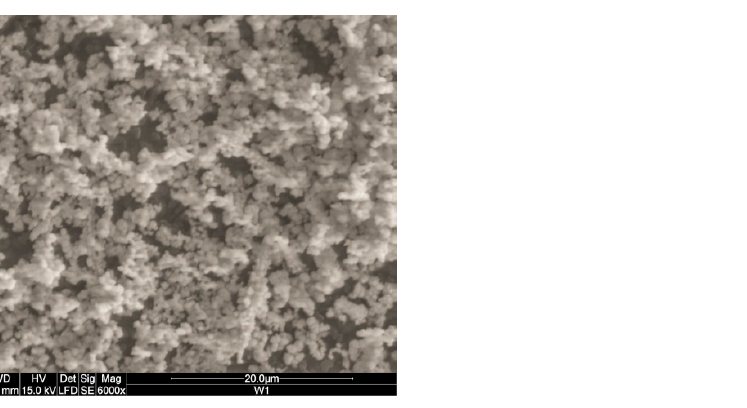
Figure 1. SEM microphotograph of synthetic vanadinite. The precipitate was aged for 2